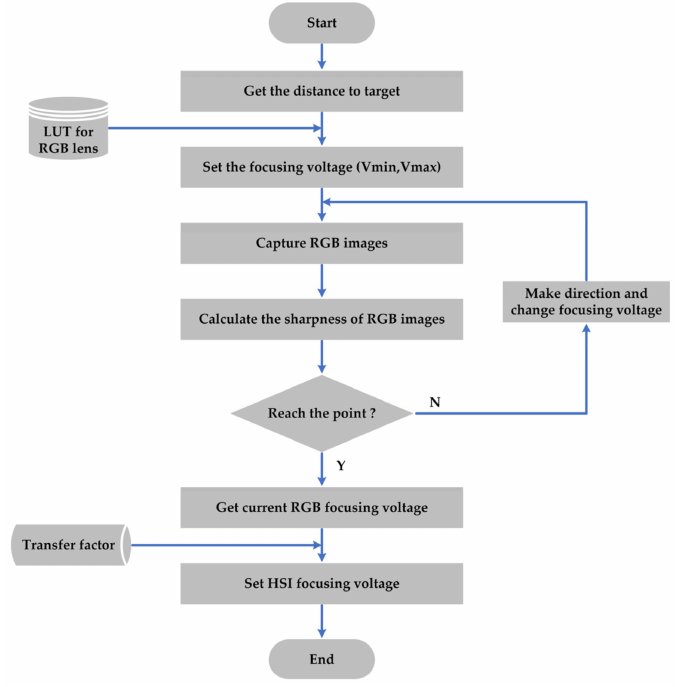
Figure 2. The flowchart of the proposed focusing transfer